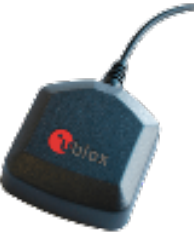
Fig. 3. NovAtel GPS-702-GG Anntena